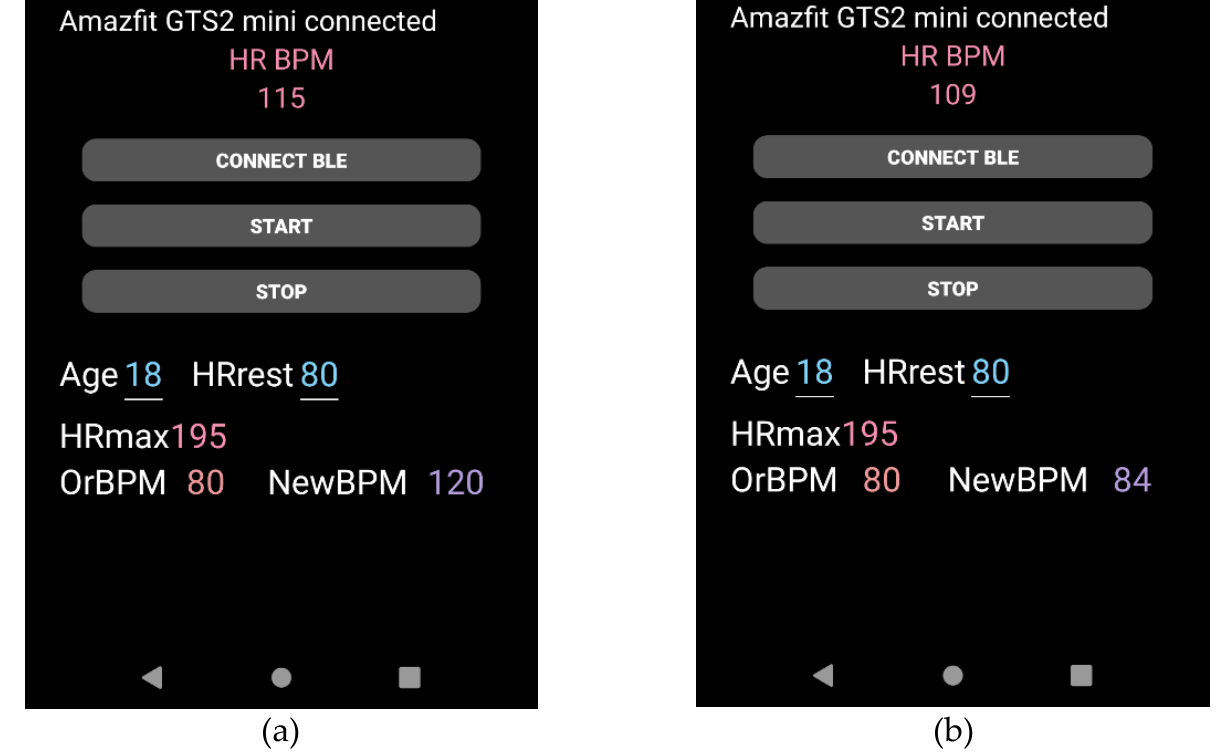
Figure 4. Two modes effects in the app, ( a ) Synchronous mode and ( b ) Asynchronous mode.